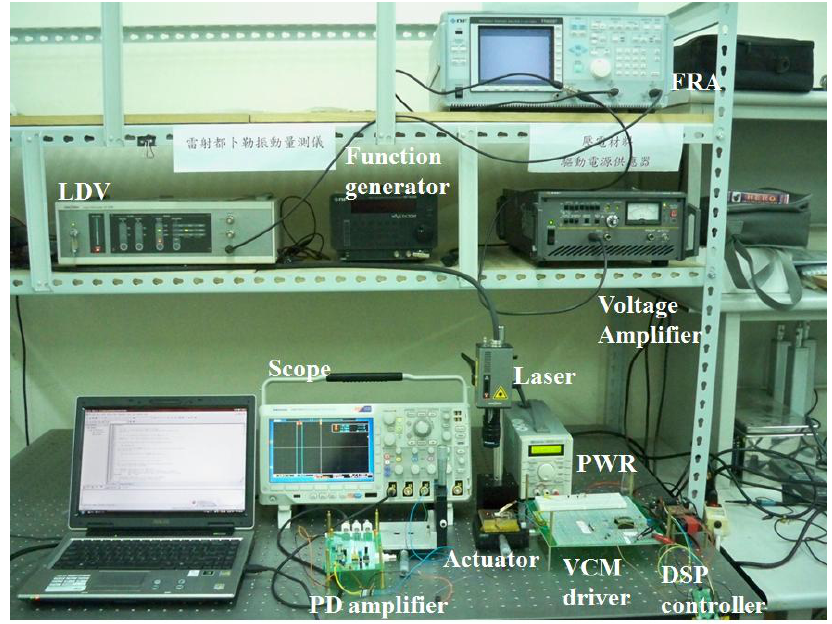
Figure 15. Experimental setup of the dual stage actuator utilized in the active vibration control scheme and measurement point of the laser vibrometer.